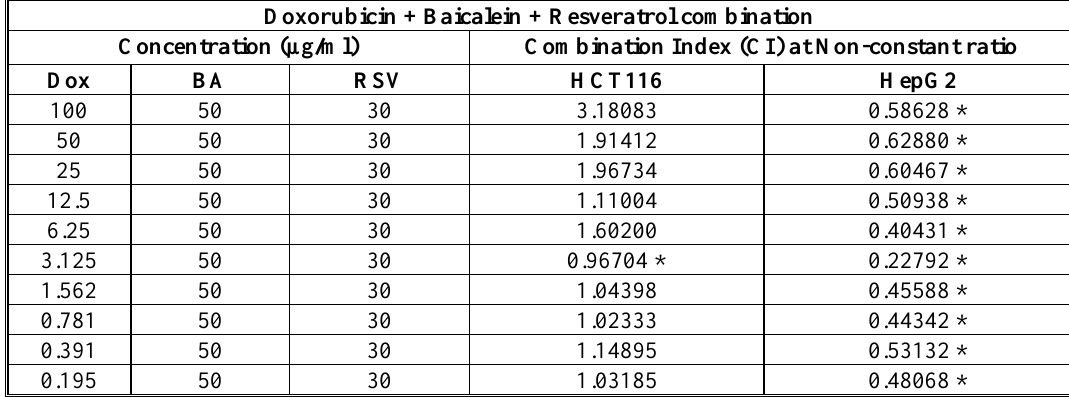
Table 3. Combination index (CI) for the combination of doxorubicin (Dox), baicalein (BA) and resveratrol (RSV) using a non-constant ratio against HCT116 and HepG2 cell lines.